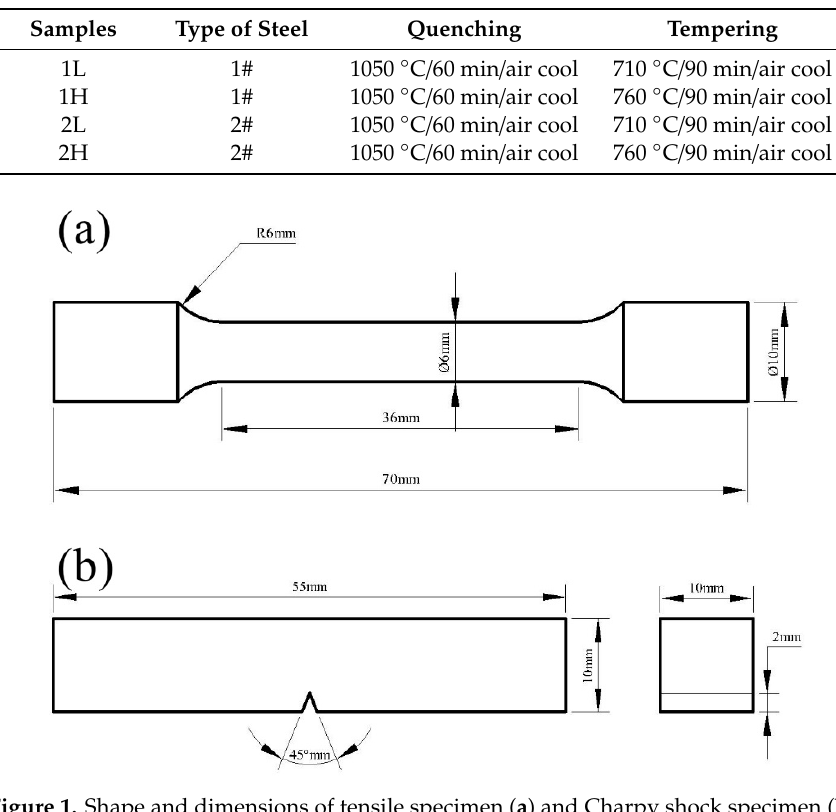
Table 2. Heat treatment conditions for four kinds of samples.